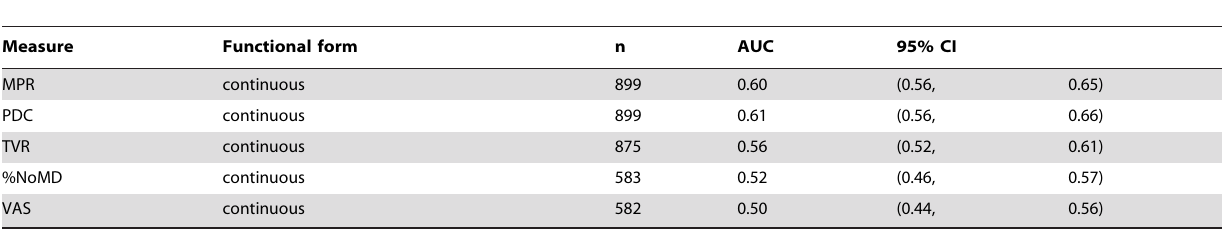
Table 4. Performance of Baseline Adherence Measures as Predictors of ART Failure at 12 Months.